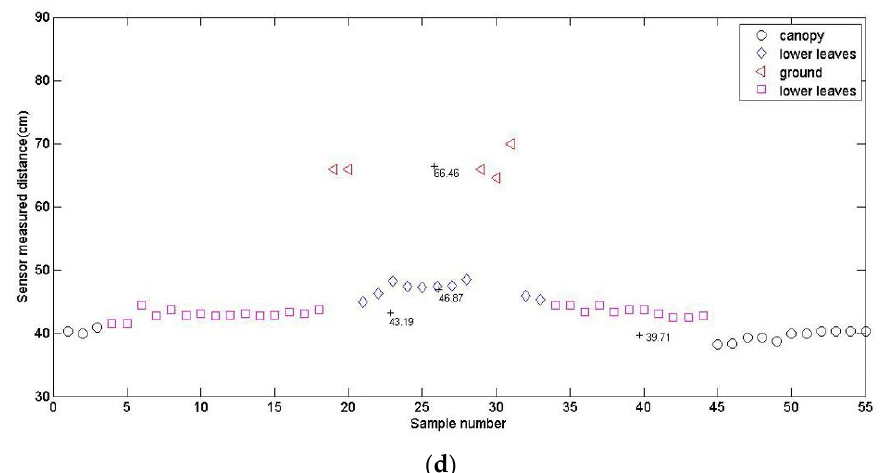
Figure 2. Clustering results for corn plants at different growth stages: ( a ) 3-leaf stage; ( b ) 4-leaf stage; ( c ) 5-leaf stage; and ( d ) 6-leaf stage.